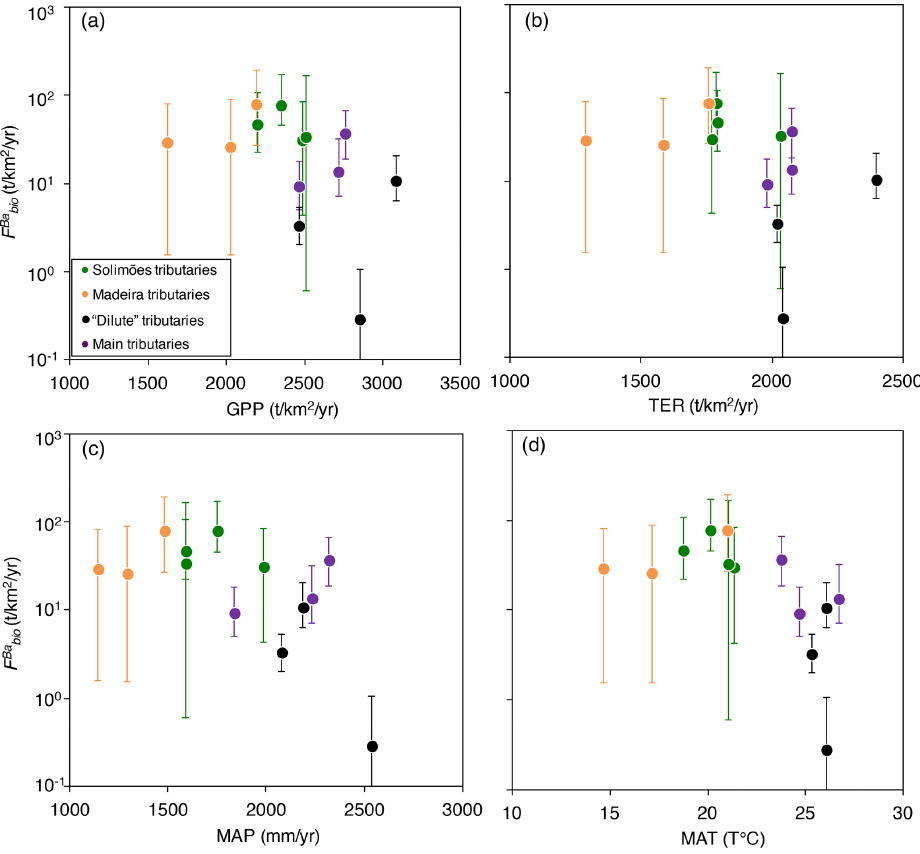
Figure 6. Flux of Ba biological uptake ( F Ba ; Eq. 9) vs. (a) gross primary production (GPP; in tkm − 2 yr − 1 ), (b) terrestrial ecosystem bio respiration (TER; in tkm − 2 yr − 1 ), (c) mean annual precipitation (MAP; in mmyr − 1 ), and (d) mean annual temperature (MAT; in T ◦ C). GPP and TER were retrieved from remote sensing data (Tramontana et al., 2016; Jung et al., 2019), and MAP and MAT were derived from https://www.worldclim.org, last access: 23 November